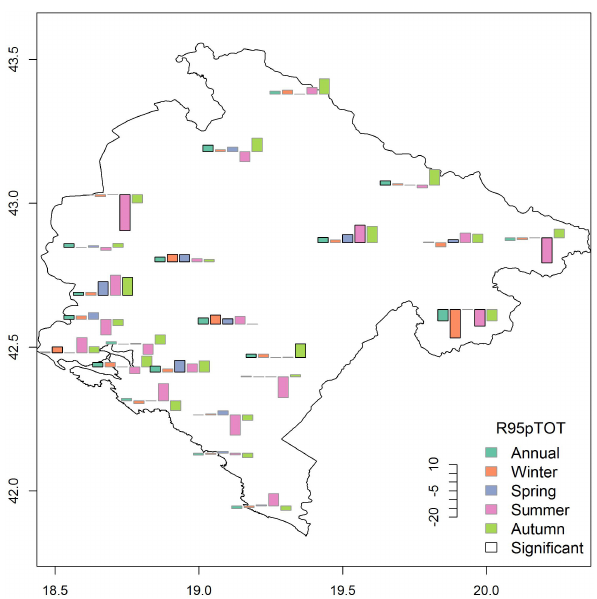
Figure 9. Decadal trends in the annual and seasonal number of days with heavy precipitation (R20mm) in daysdec − 1 .